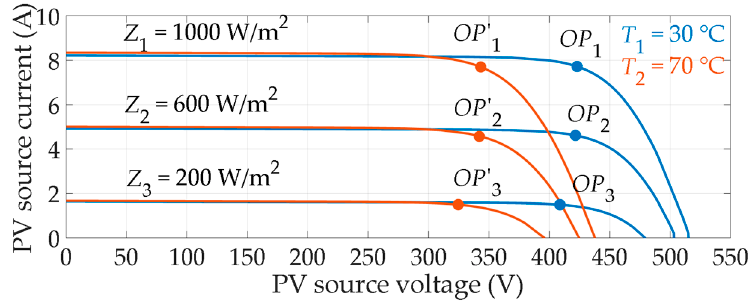
Figure 9. I-V characteristics of the utilized PV source.